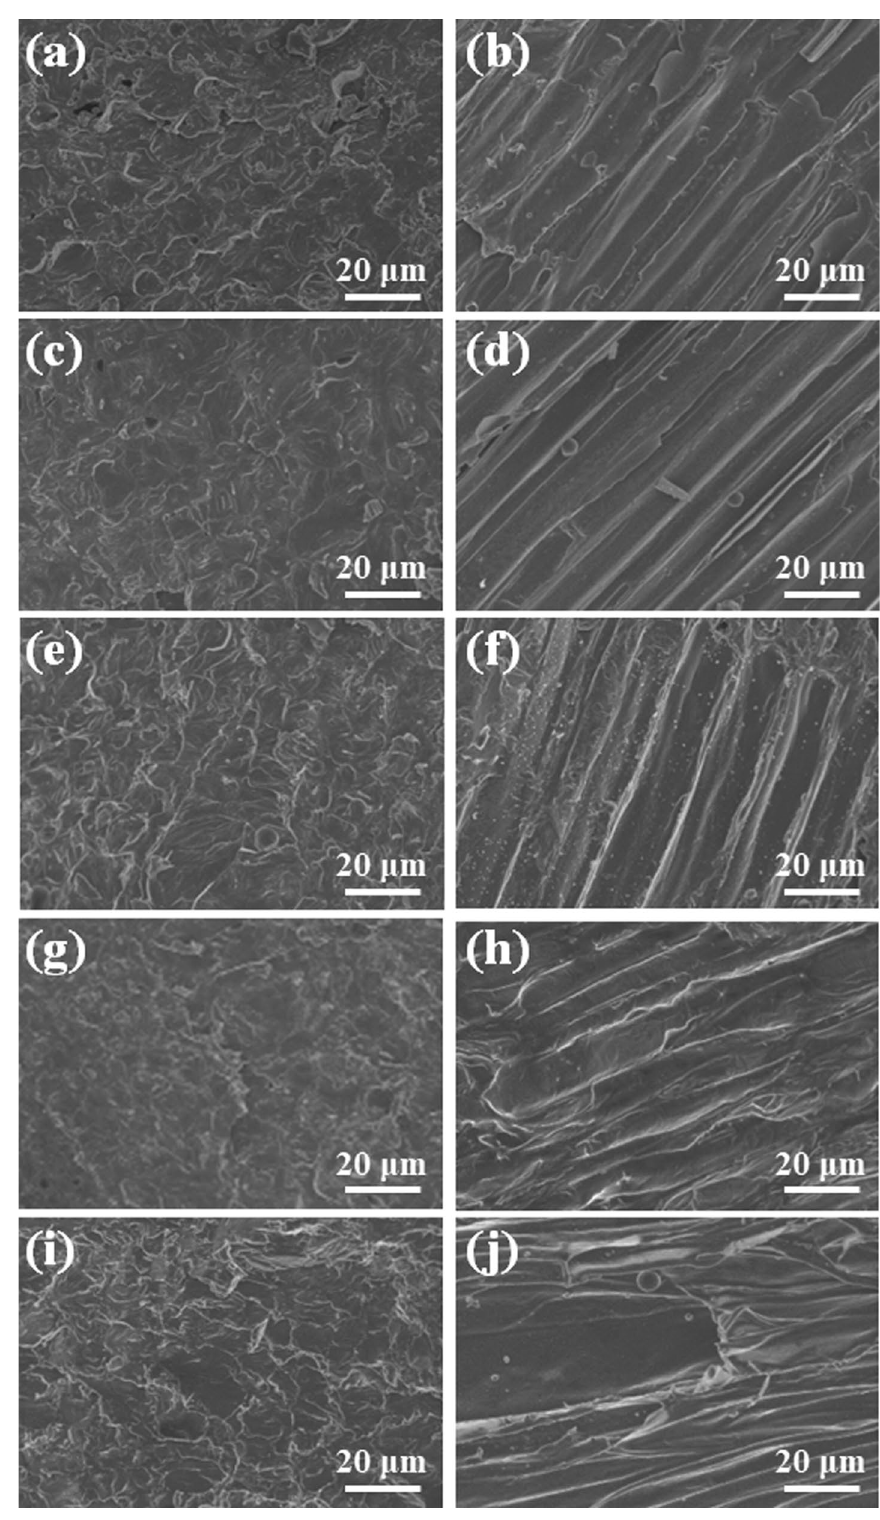
Fig. 6 SEM images of cross sections of a